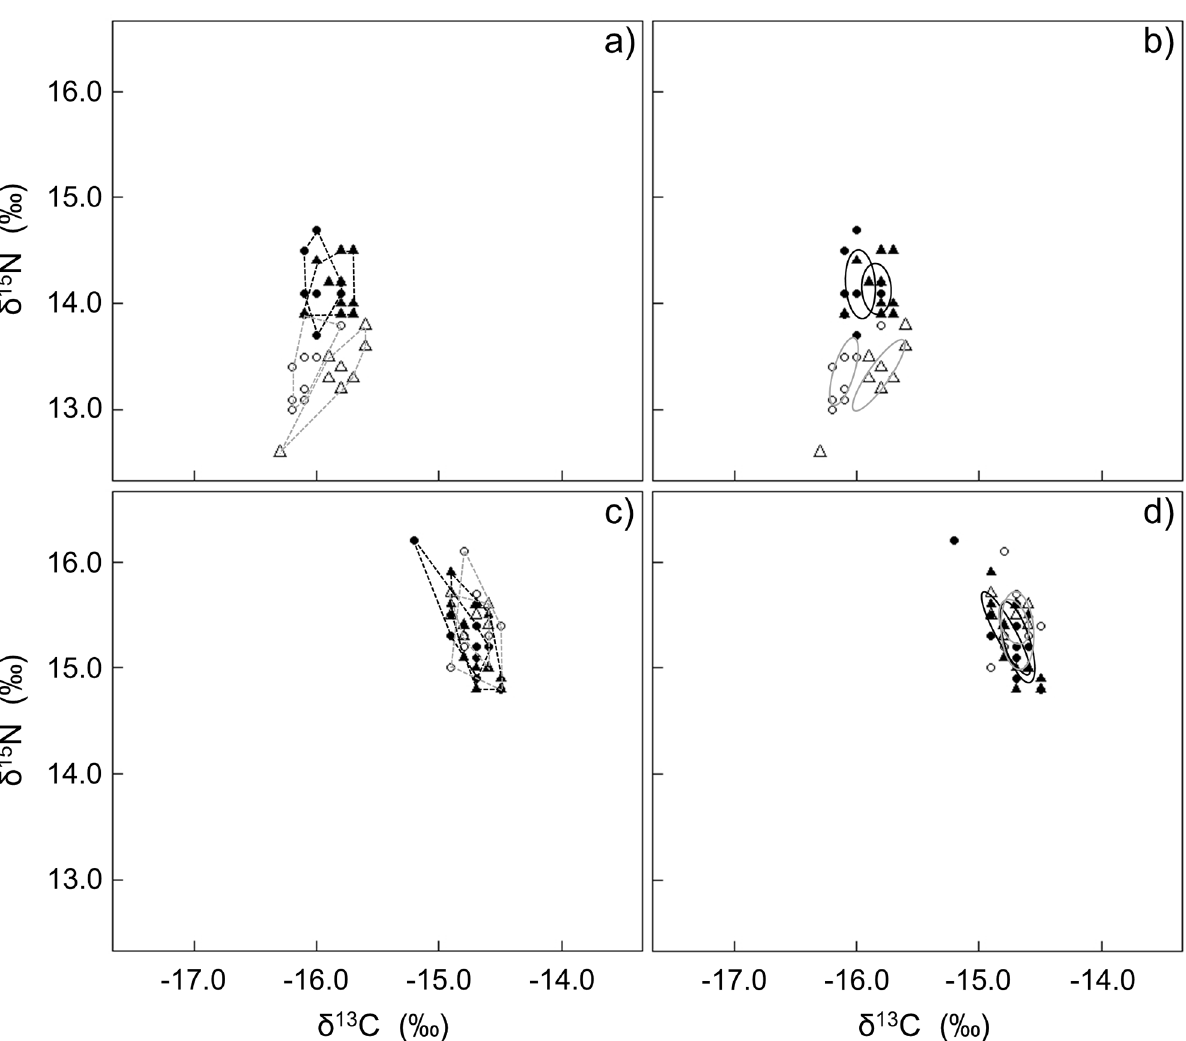
Fig 2. Seasonal variation in the isotopic space depicting niche areas for African penguin blood (a, b) and feathers (c, d) using convex hull areas (a, c; [31]) and standard ellipse areas corrected for small sample size (b, d; [30]). Females (circles) and males (triangles) were sampled in both non-breeding and breeding periods on Bird Island and are represented in black and grey, respectively.